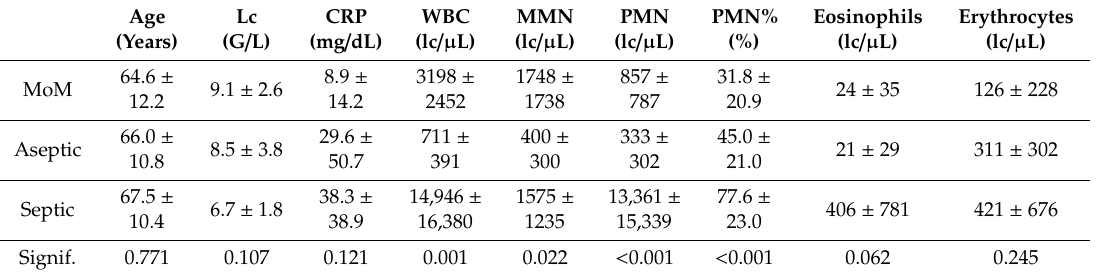
Table 2. Demographics, blood diagnostics and synovial fluid